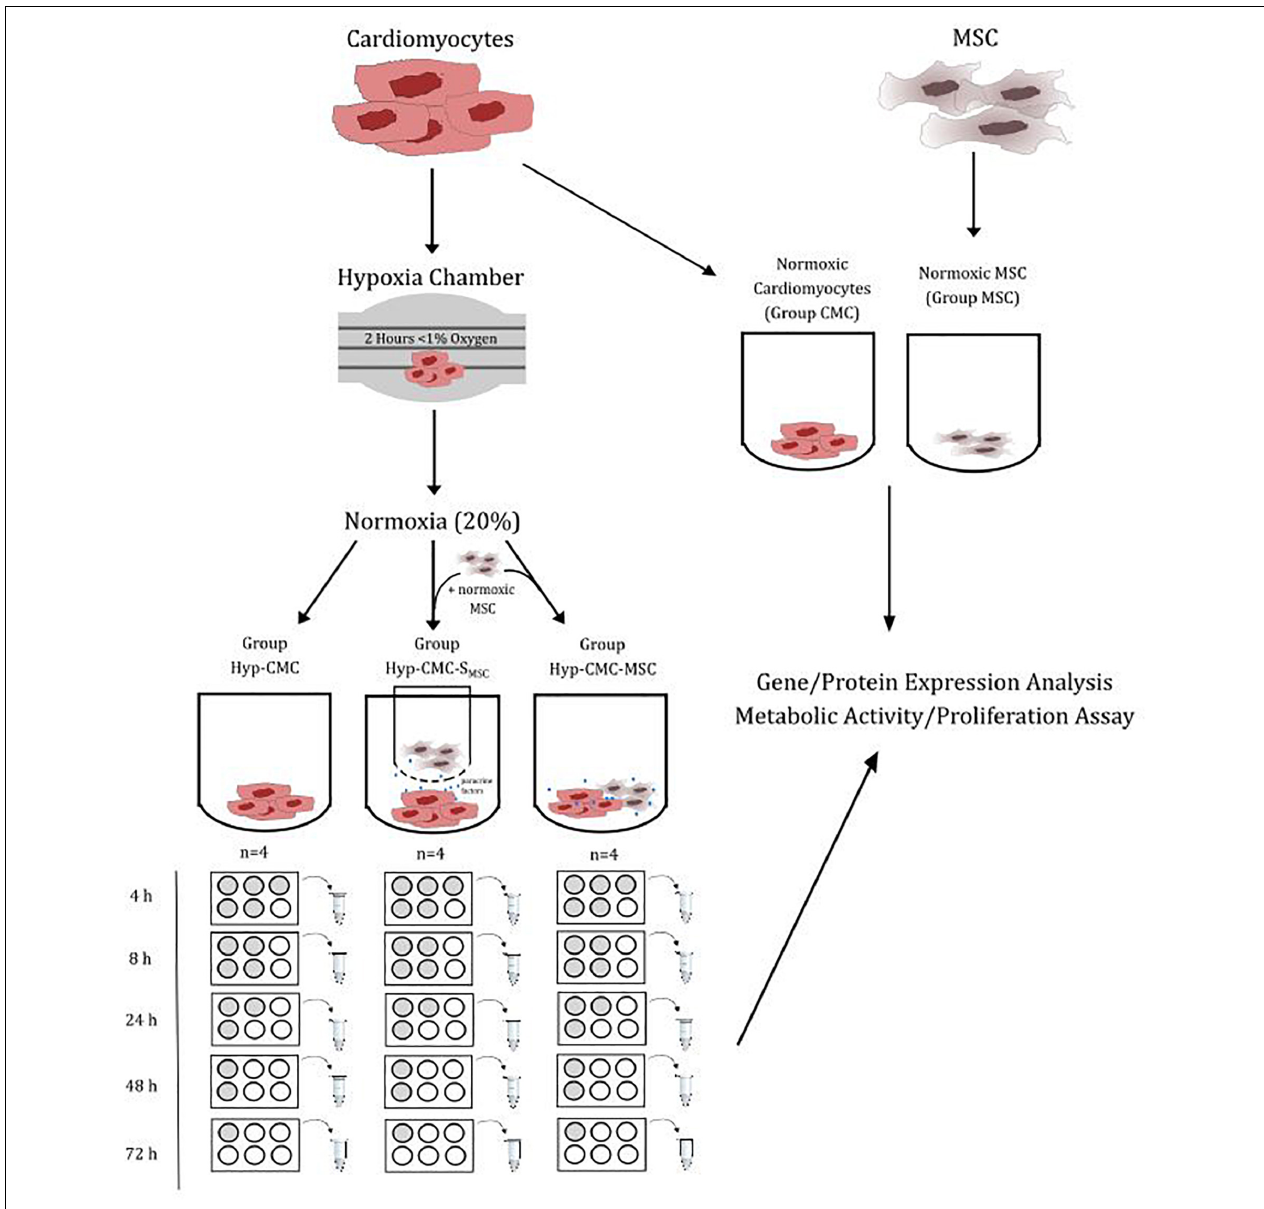
FIGURE 1 | Overview of the study design setup. CMC were exposed to < 1% oxygen level for 2 h. After restoration of the normoxic condition, the CMCs were separated in three groups: Unstimulated hypoxic CMC (Hyp-CMC), CMC stimulated with MSC secretome (Hyp-CMC-S MSC ) and CMC stimulated directly with MSC (Hyp-CMC-MSC). The samples of each setup were analyzed after the respective reoxygenation period. Additionally, normoxic CMC (CMC) and normoxic MSC (MSC) were analyzed. Each setup was evaluated using gene/protein analysis and a proliferation assay. MSC – Mesenchymal stem cells. CMC – cardiomyocytes. Hyp –